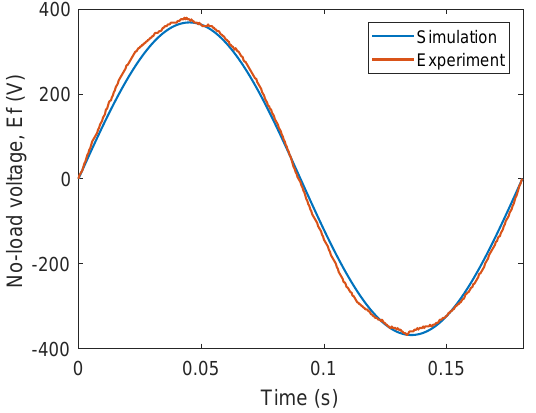
Figure 4. Comparison of results from the simulation method and from experiments. Data from experiments are reused from [25] licenced under CC BY 3.0